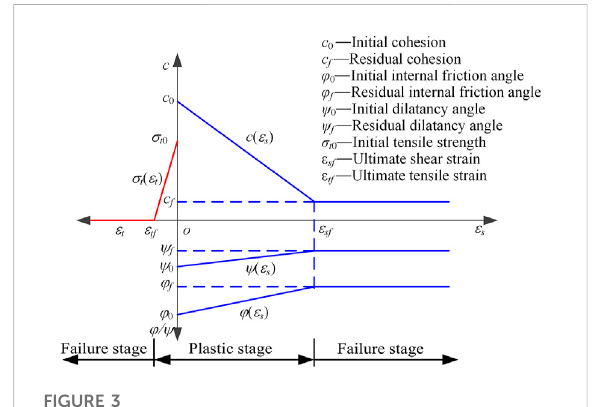
FIGURE 3 Sketch of strain-softening model strength